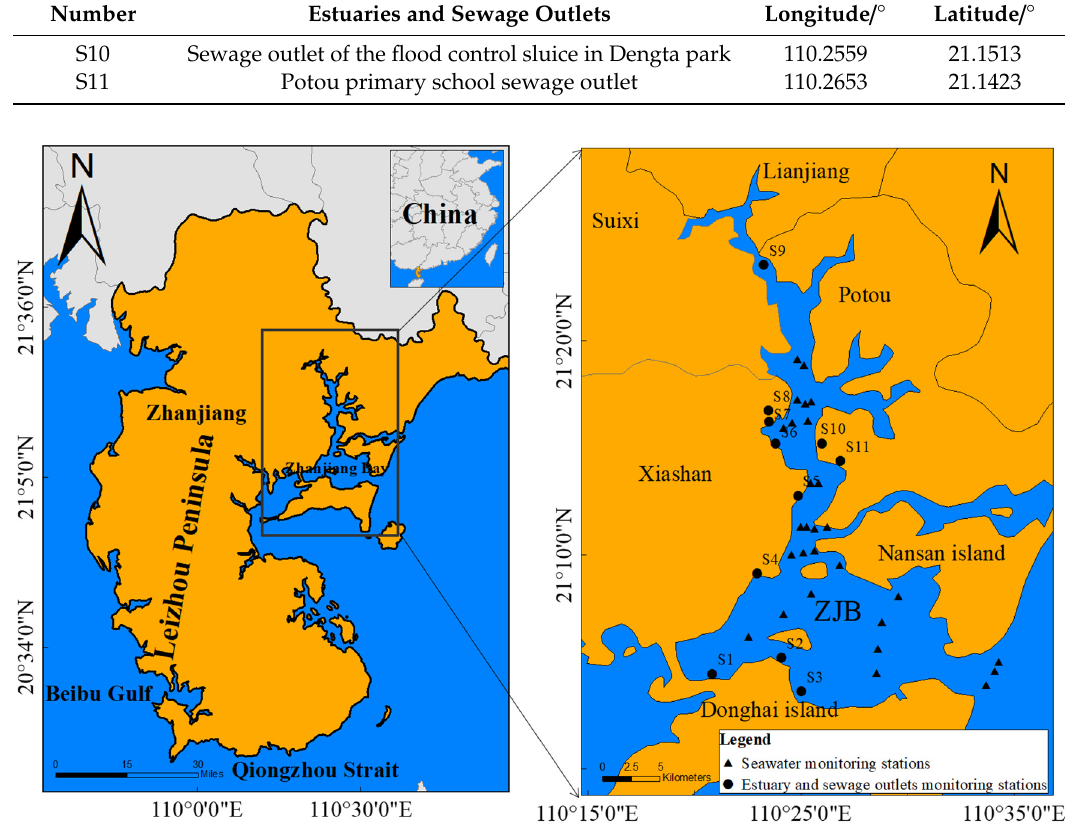
Figure 1. Geographic location, terrestrial source pollutants, and seawater monitoring stations in ZJB. Table 1. Investigation of estuaries and sewage outlets in ZJB [29].